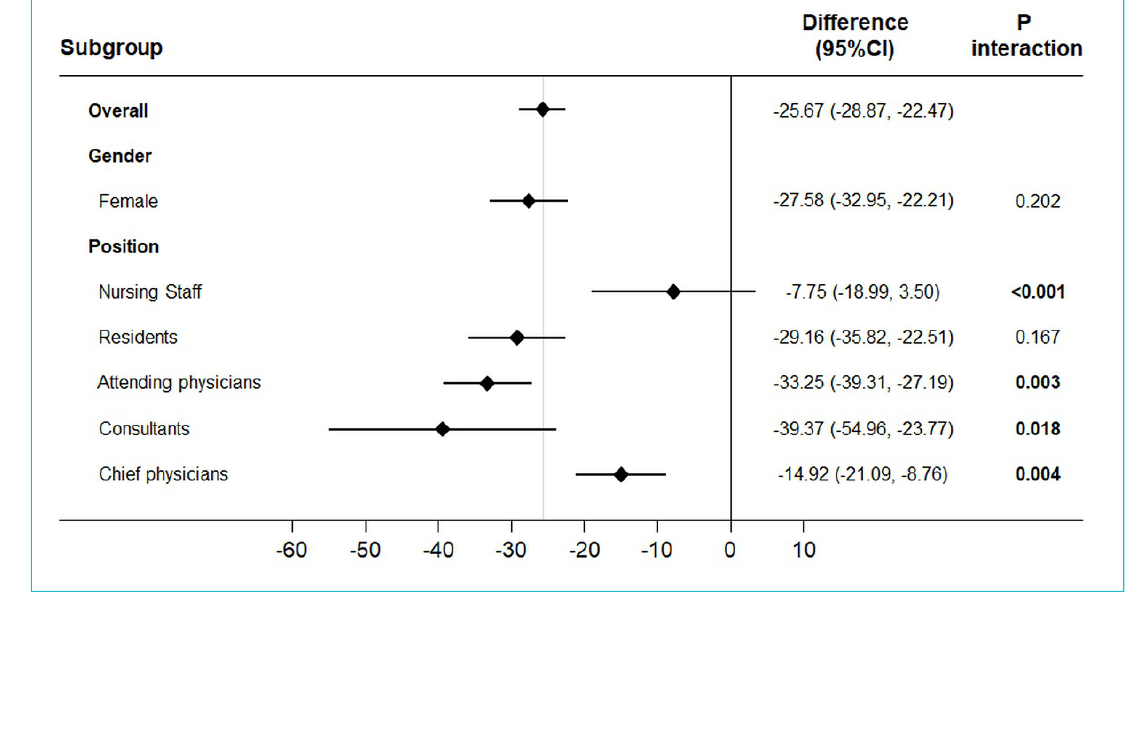
Figure S2: “Being able to discuss sensitive topics” in different subgroups . All differences calculated with multivariate linear regression models for continuous